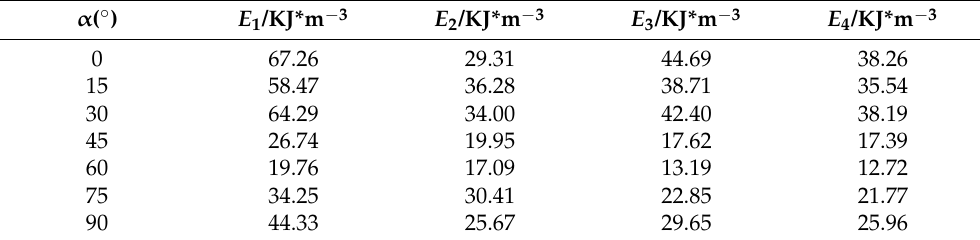
Table 3. Characteristic energy parameters of coal at different azimuth angles.